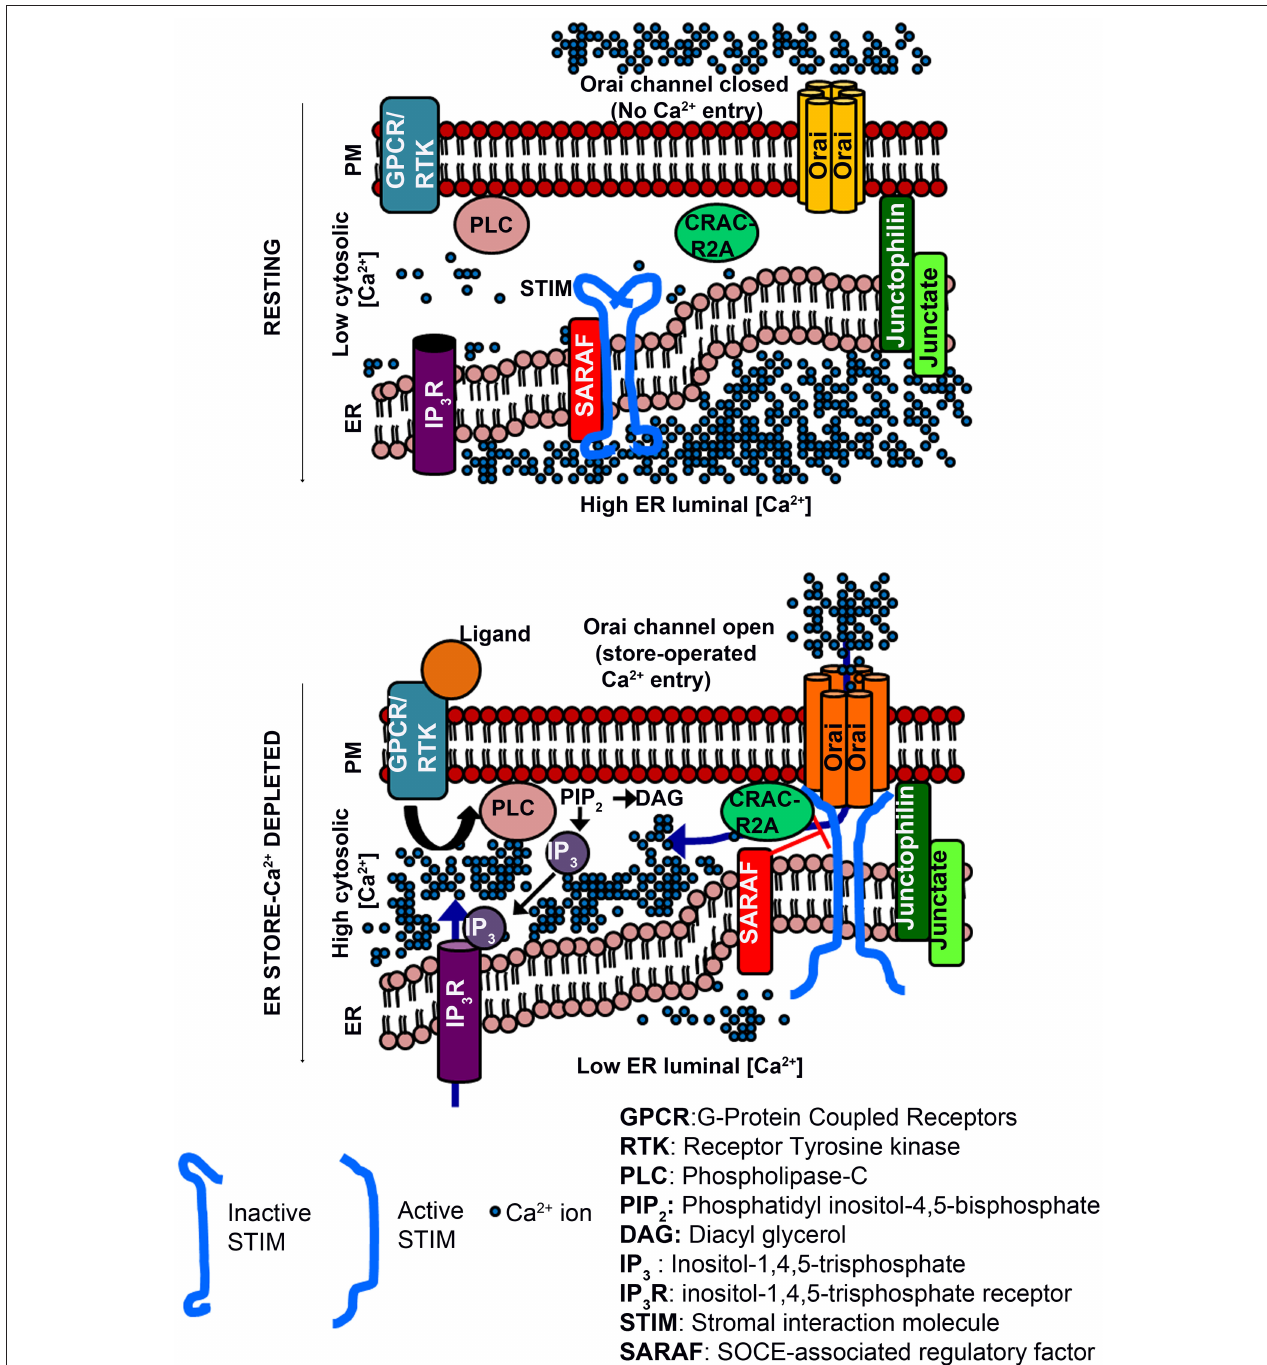
FIGURE 1 | Activation of Orai channels by STIM proteins during store-operated Ca 2 + entry (Top). Cytosolic [Ca 2 + ] is low compared to the ER luminal [Ca 2 + ]. STIM proteins (inactive form) reside in regions of ER distal from the PM. Orai channels (closed) are distributed in the PM. ER-membrane resident Junctate and Junctophilin proteins (positive regulators of SOCE) help in pre-organizing ER-PM contact sites that facilitate STIM recruitment to the PM-proximal regions of the ER. (Bottom) Binding of an extracellular ligand to a PM-resident GPCR/RTK activates PLC and generates IP 3, which binds to ER-resident IP 3 R, and is followed by ER store-Ca 2 + release through the IP 3 R. The lowering of ER luminal [Ca 2 + ] activates STIM, which translocates to ER-PM regions where it binds to and opens Orai channels. CRACR2A is a positive regulator of SOCE that helps stabilize STIM/Orai complexes. SARAF is a negative regulator, which destabilizes STIM/Orai clusters to prevent excessive Ca 2 + refilling. Hexameric Orai channels are depicted in accordance with the crystal structure of Drosophila Orai.